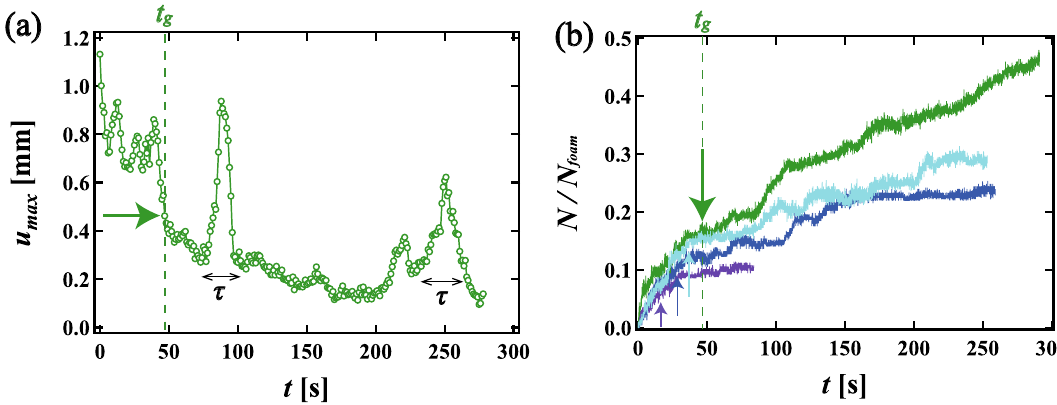
Figure 2. ( a ) The time evolution of the maximum of the displacement vector during the time interval (cid:31) t = 10 s at φ 2 D = 0.11 in a monodisperse foam. t = 0 s is the time just after the solution is injected. The effect of the injection can be neglected after t g , the green arrow in ( a ). Sharp peaks are found around 80 s and 250 s. These times correspond to large collective rearrangement events. τ is the interval from the start to the end of a single, discrete rearrangement event. ( b ) Cumulative number of rearranged bubbles N / N foam during the relaxation process as a function of time t , where N foam is the total number of bubbles. Each line corresponds to N at φ 2 D = 0.110 (green), 0.093 (light blue), 0.061 (blue) and 0.042 (purple). Arrows correspond to t g as shown in ( a